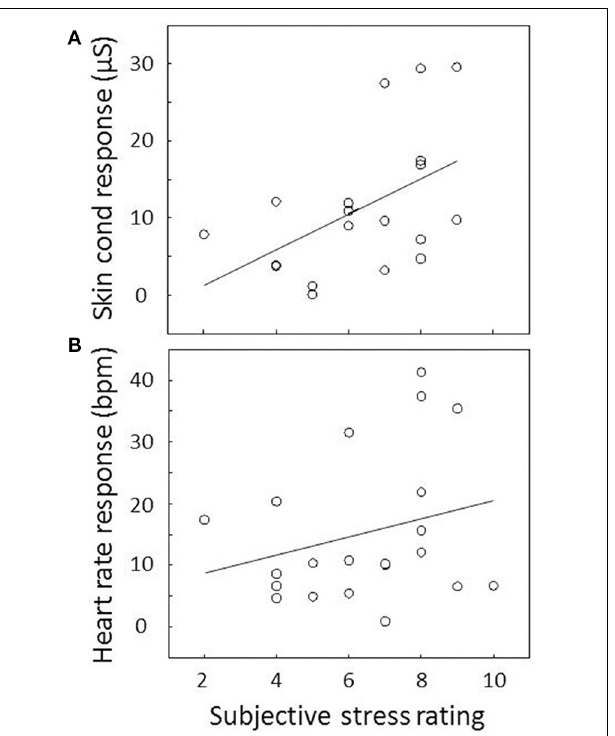
FIGURE 3 | Association between subjective stress and (A) skin conductance and (B) heart rate response. Responses are determined by the difference in average skin conductance level or heart rate between the 9th and the 10th block and plotted against subjective stress rating for each participant. The correlation between subjective stress and skin conductance response was significant; the correlation between subjective stress and heart rate response was not. The plotted lines are linear regression lines.